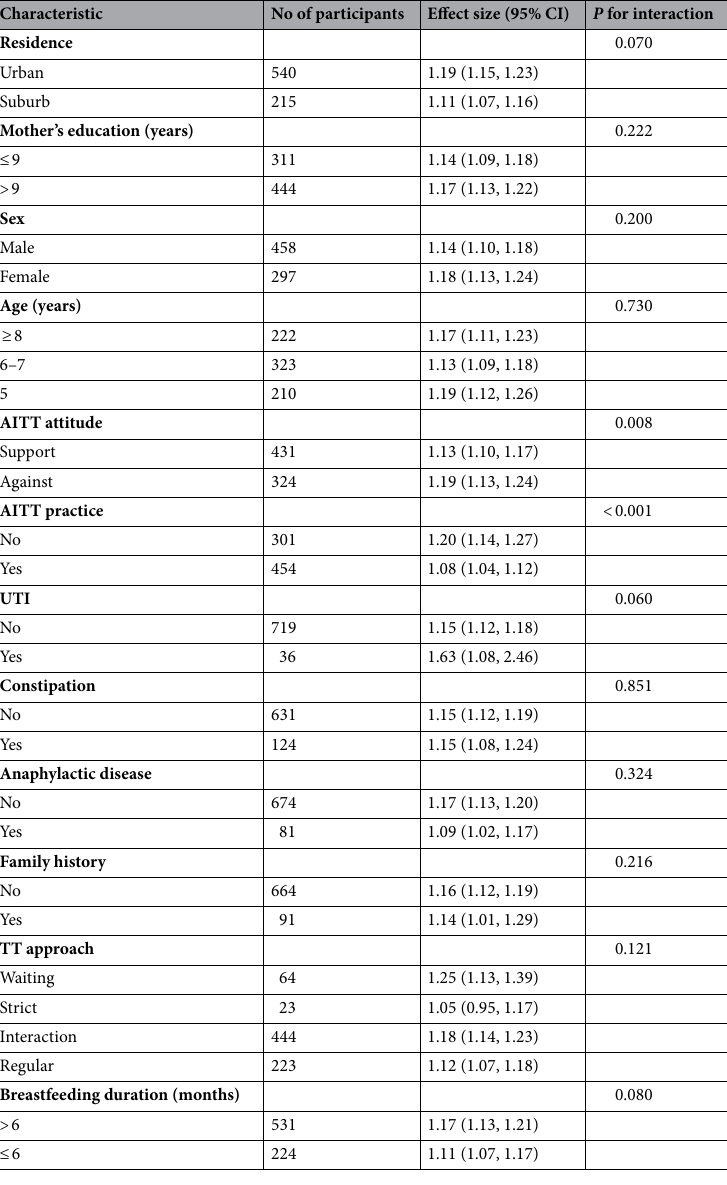
Table 4. Effect size of Daytime DD use cessation age on Enuresis and exploratory subgroups. DD disposable diaper, AITT assisted infant toilet training, TT toilet training, UTI urinary tract